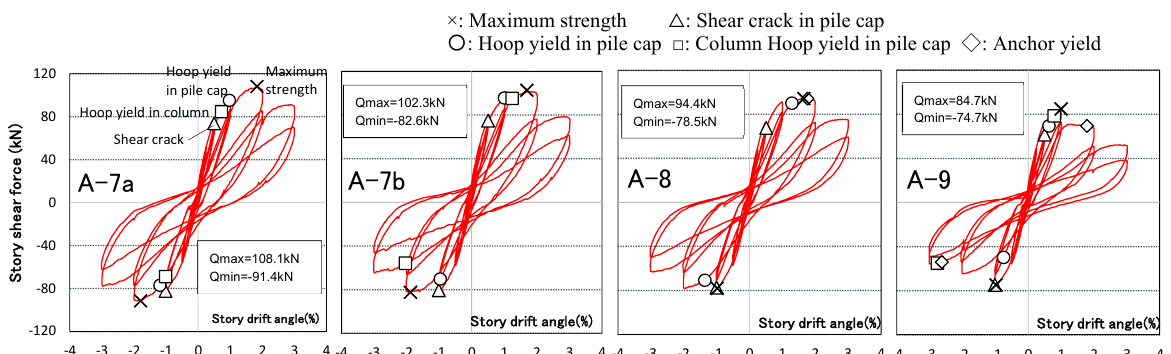
Figure 4. Details of Specimens.